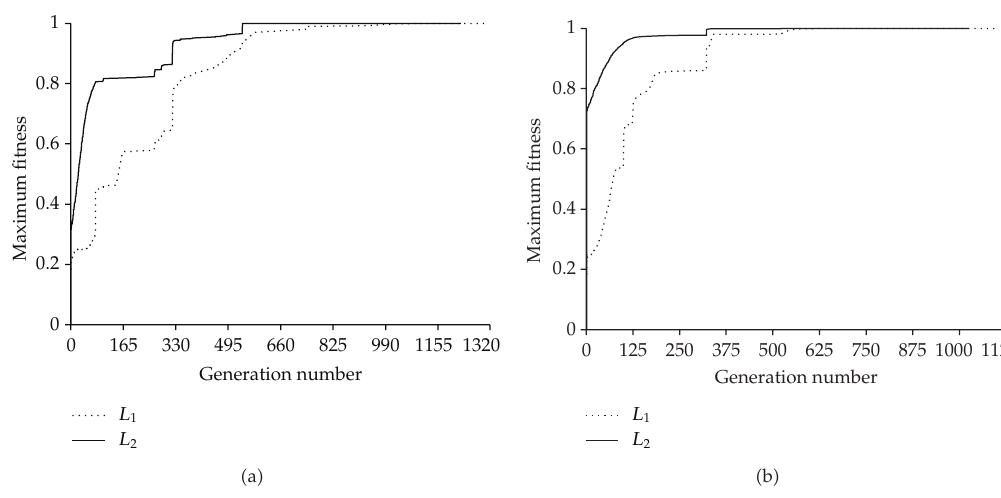
Figure 8: Evolutionary progress plots for the best-of-generation individual using L 1 and L 2 vector norms for (cid:3) a (cid:4) Problem 2; (cid:3) b (cid:4) Problem 3.